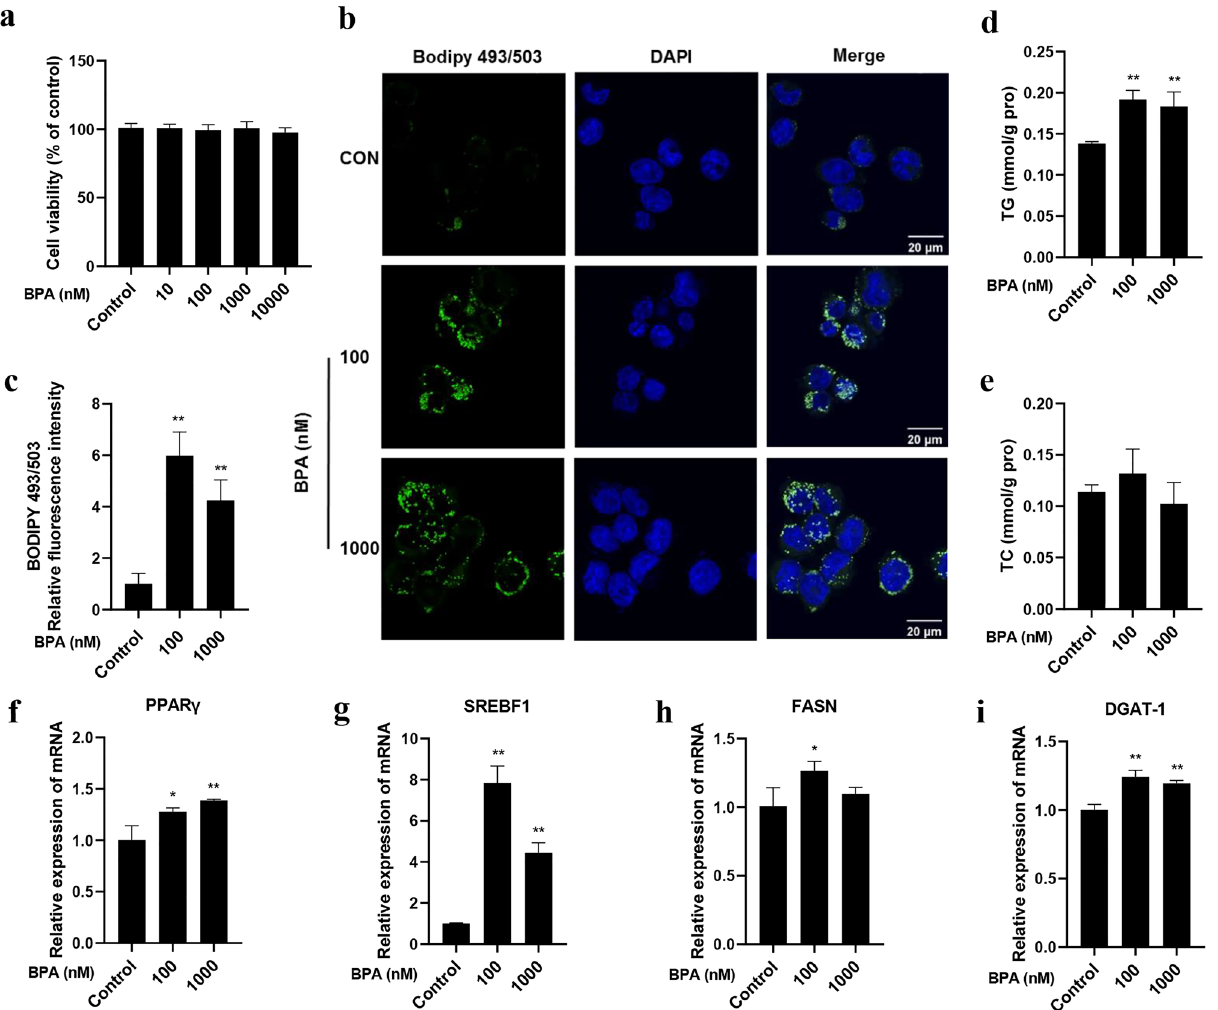
Figure 1. BPA promoted lipid accumulation in LO2 cells. ( a ) Different concentrations of BPA (10, 100, 1000, 10,000 nM) were added to LO2 cells for 24 h, and MTT assay was performed to assess the cell viability. ( b ) BODIPY 493/503 staining was performed for lipid droplets. Scale bar = 20 μm. ( c ) The relative quantification of BODIPY 493/503 fluorescence intensity. ( d ) TG levels and ( e ) cholesterol levels in LO2 cells. The mRNA expression levels of ( f ) PPARγ, ( g ) SREBF1, (h) FASN and ( i ) DGAT-1 were measured by qRT-PCR. Data were expressed as the mean ± SD of 3 independent experiments. * p < 0.05 and ** p < 0.01, compared with control